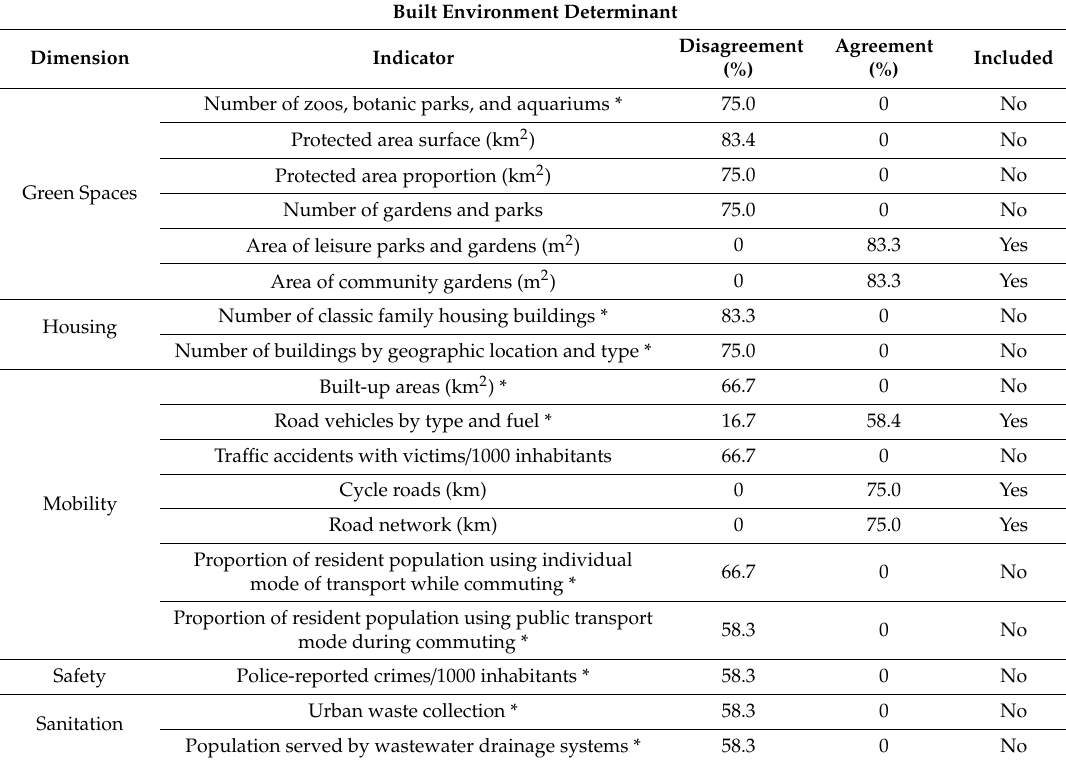
Table 2. List of the 34 indicators retrieved from the literature and from databases search, and synthesis of experts’ opinions collected in the semi-structured interviews regarding the relevance of indicators in monitoring and assessing EH in the Lisbon urban